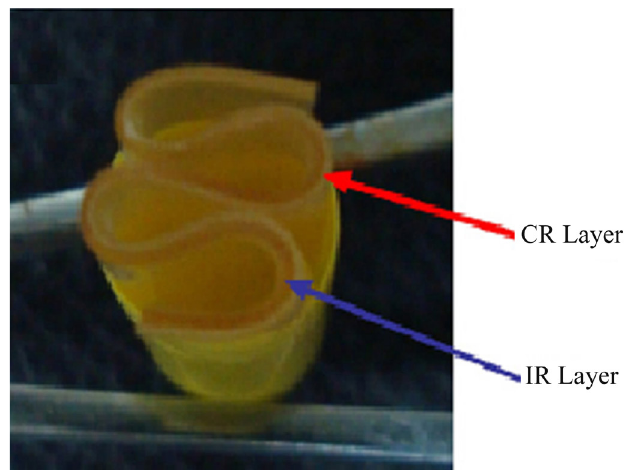
FIGURE 2 - Folding pattern of film for gastroretentive bilayer film of furosemide. (Darandale, Vavia,